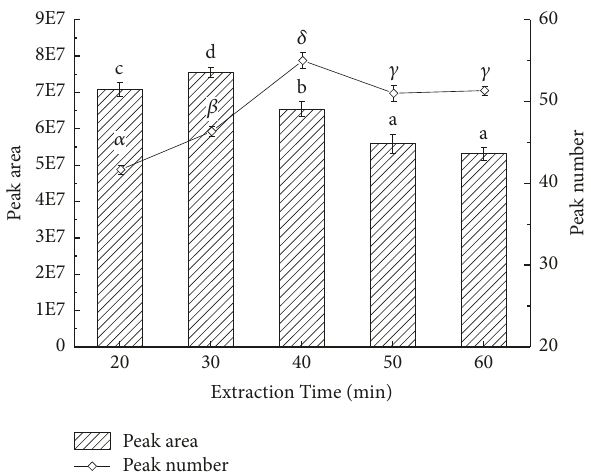
Figure 8: Effects of extraction time on volatile compounds of pepper chicken soup. English letters “a”, “b”, “c” indicate Duncan’s multiple range test among peak areas of the five extraction times. Greek letters “ 𝛼 ”, “ 𝛽 ”, “ 𝛾 ”, “ 𝛿 ” indicate Duncan’s multiple range test among peak numbers of the five extraction times. Data in the same group marked with different letters mean significant difference ( p < 0.05) and the same letters denote not significant difference ( p <